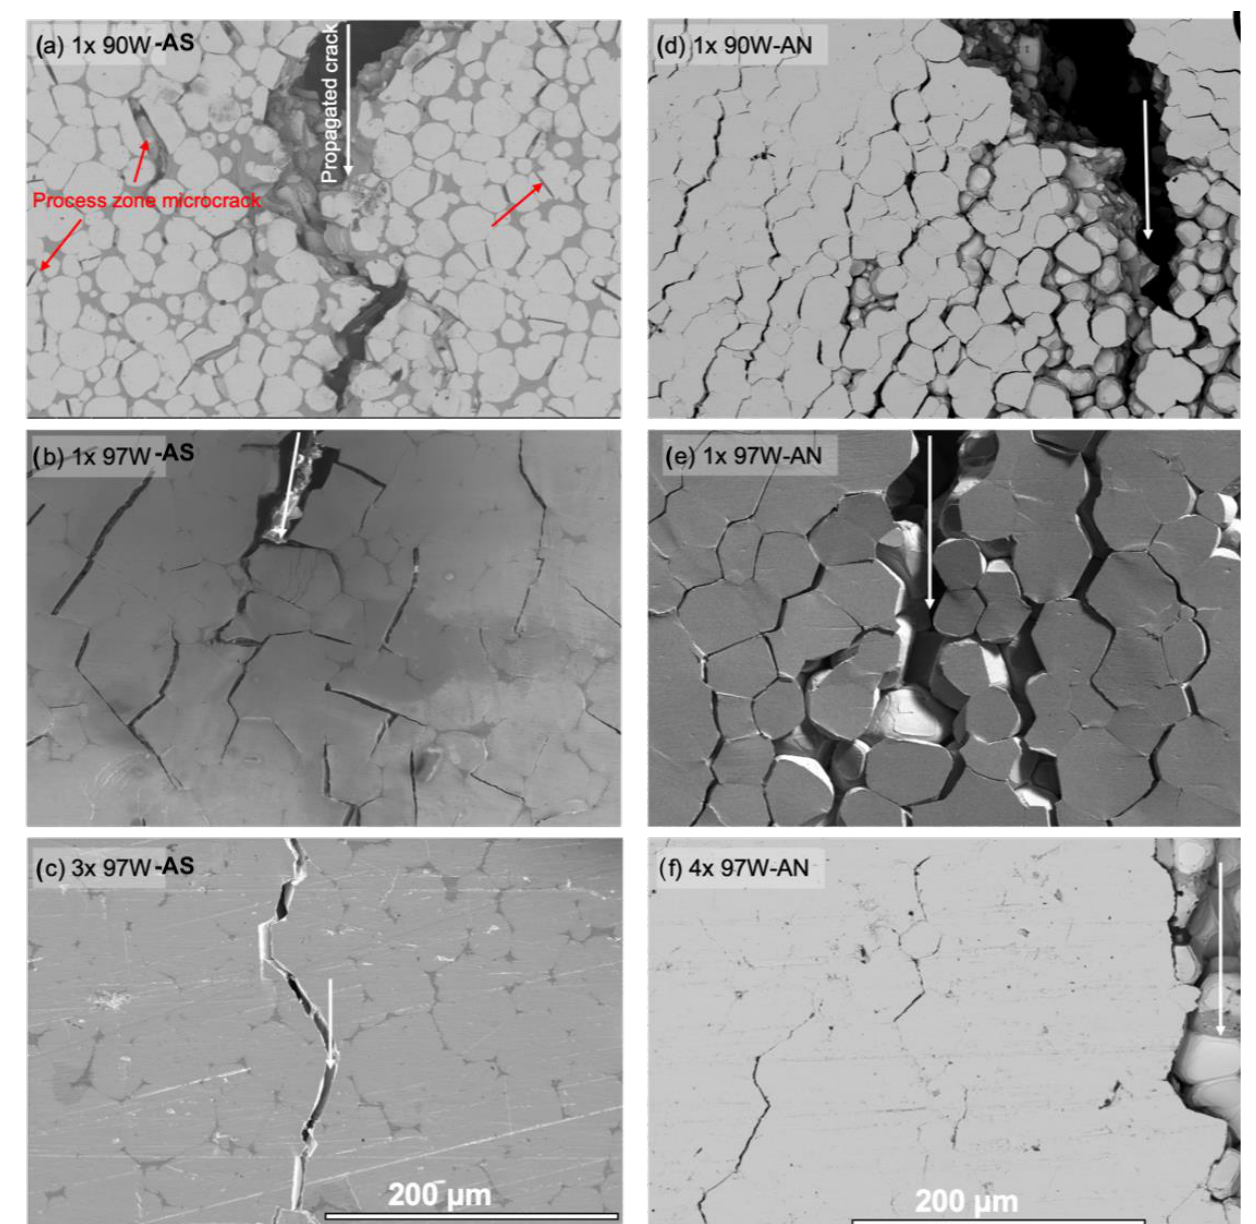
Figure 9. Higher magnification SEM images of 1× 90 to 97W propagating cracks in the AS ( a – c , left column) and AN ( d – f , right column) conditions. Note, (f) is for a fully fractured specimen. The white arrows show the crack propagation direction, and the red arrows show some WC microcracks. The scale is 200 µm in all cases.